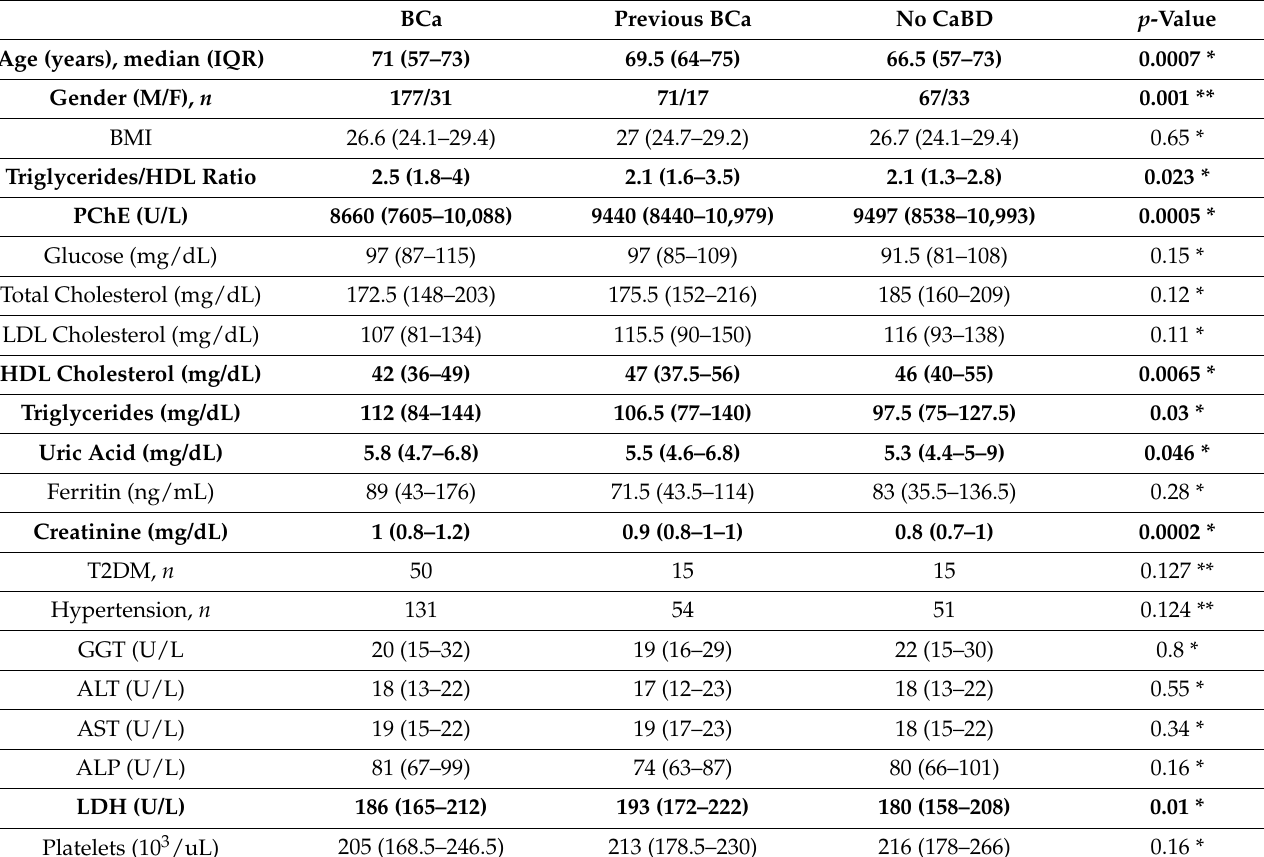
Table 1. Characteristics of